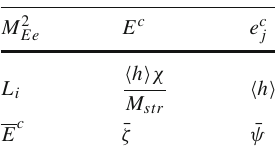
Table 7 Mixing between the vector like leptons and the electrons